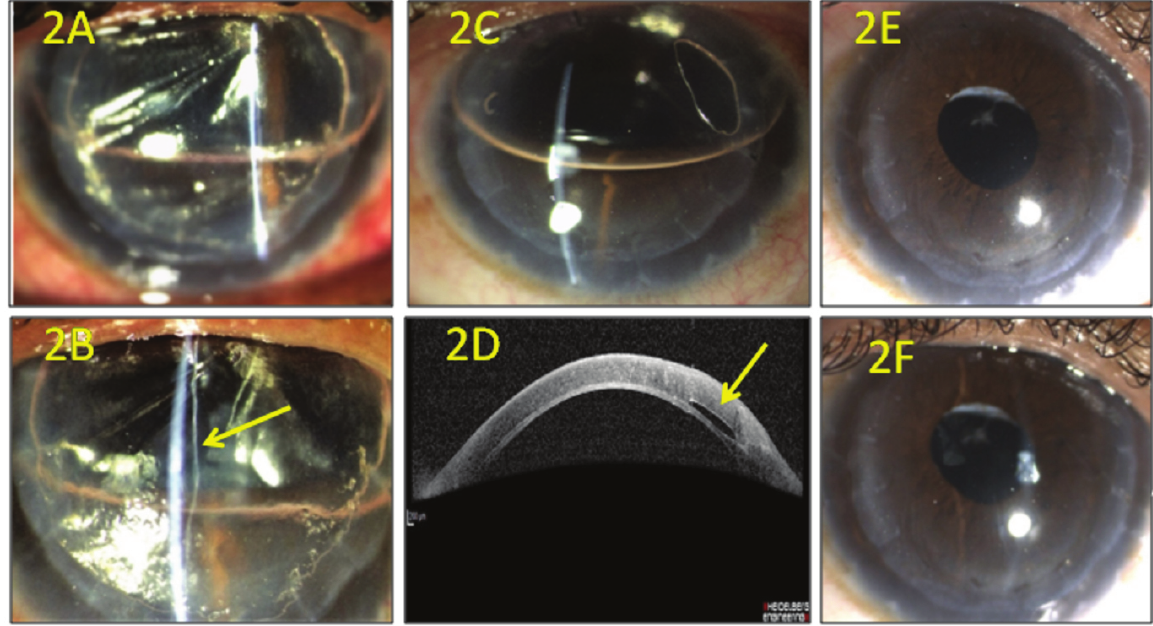
Figure 2. (a) Day 1 after C3F8 gas tamponade, with gas bubble in anterior chamber (AC) and gas bubble entrapment between the lamellae. (b) Magnified slit view shows entrapped gas bubble in the potential space between anterior and posterior lamellae. (c) Immediate reattachment of anterior and posterior lamellae after slit-lamp drainage of entrapped gas bubble with only a small residual gas bubble. (d) Anterior segment optical coherence tomography after gas bubble drainage shows reattachment of lamellae and a small residual gas bubble in the interface. (e and f) Clear graft with well-placed intraocular lens at the 18-month